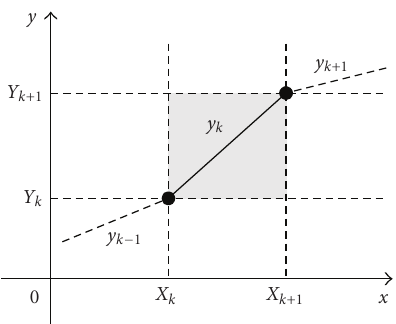
Figure 2: A k th segment belonging to a PWL